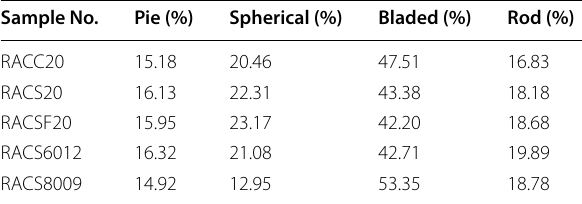
Table 8 Statistics of the proportions of the four types of pores in different specimens Sample No.